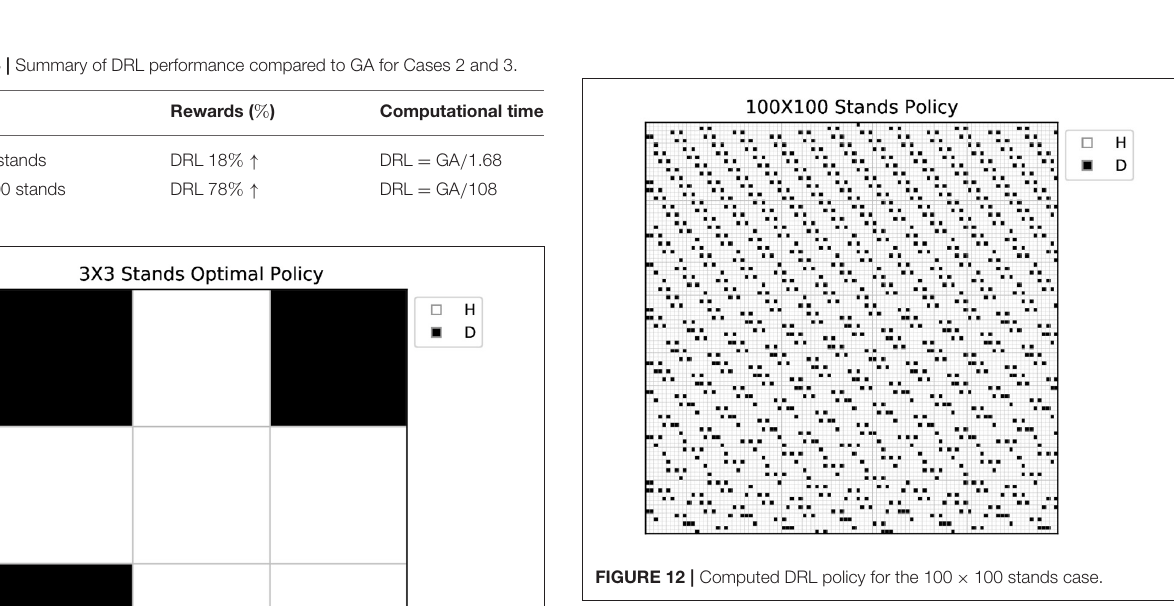
a large-scale model. Figure 9 for the 100